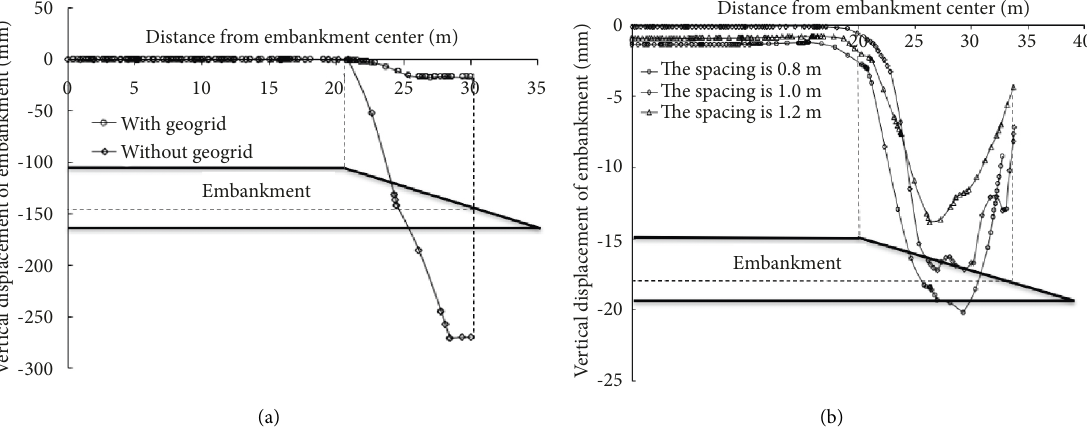
Figure 15: Position effect analysis of geogrid reinforcement. (a) Presence of reinforced. (b) Muscle layer spacing.